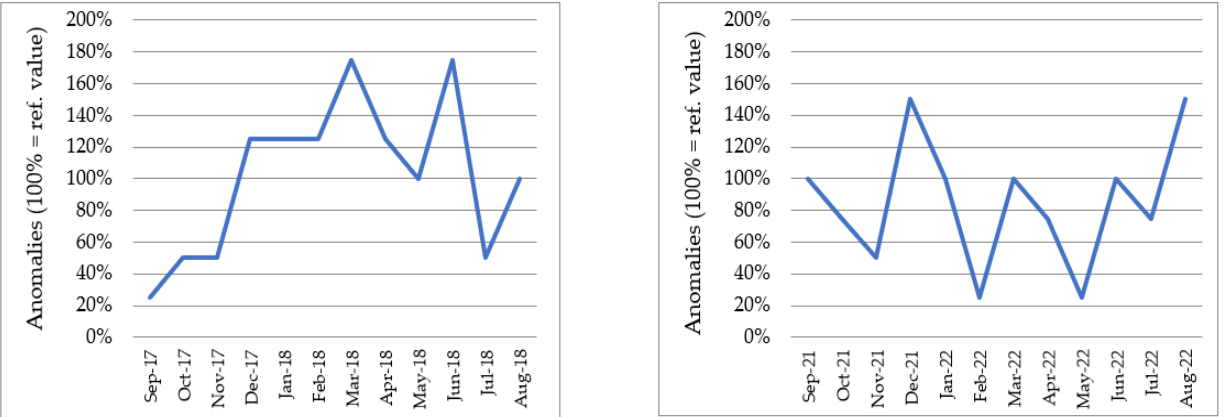
Figure 19. Rainfall anomalies in the upper Gállego River basin. Hydrological year 2017/2018 (left) and 2021/2022 (right). Over reference period 1981 – 2010, as determined by AEMET for these comparisons. Data source and methodology: AEMET [37,38,55].